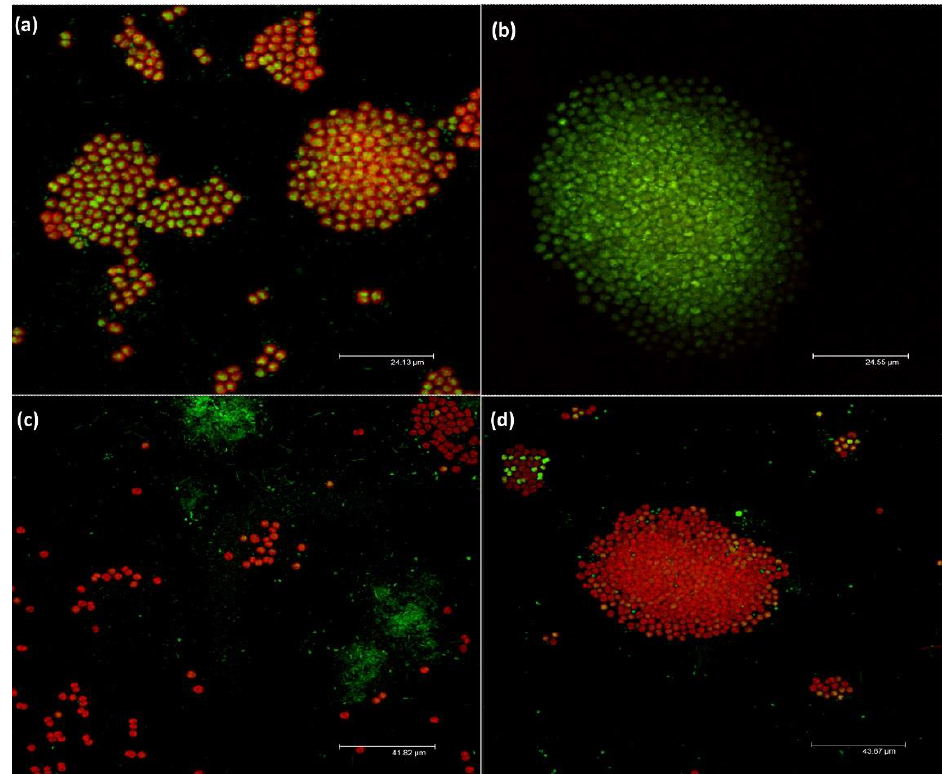
Figure 5. Confocal laser scanning micrographs of M. aeruginosa and bacterial community, labeled with SybrGreen at the end of the experiments in the different treatments. ( a ) NC, ( b ) PC, ( c ) MIC and ( d ) MIC/2. Red: pigment autofluorescence; SybrGreen stained DNA fluorescence.